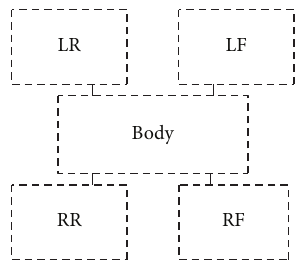
Figure 5: The whole BG model of the